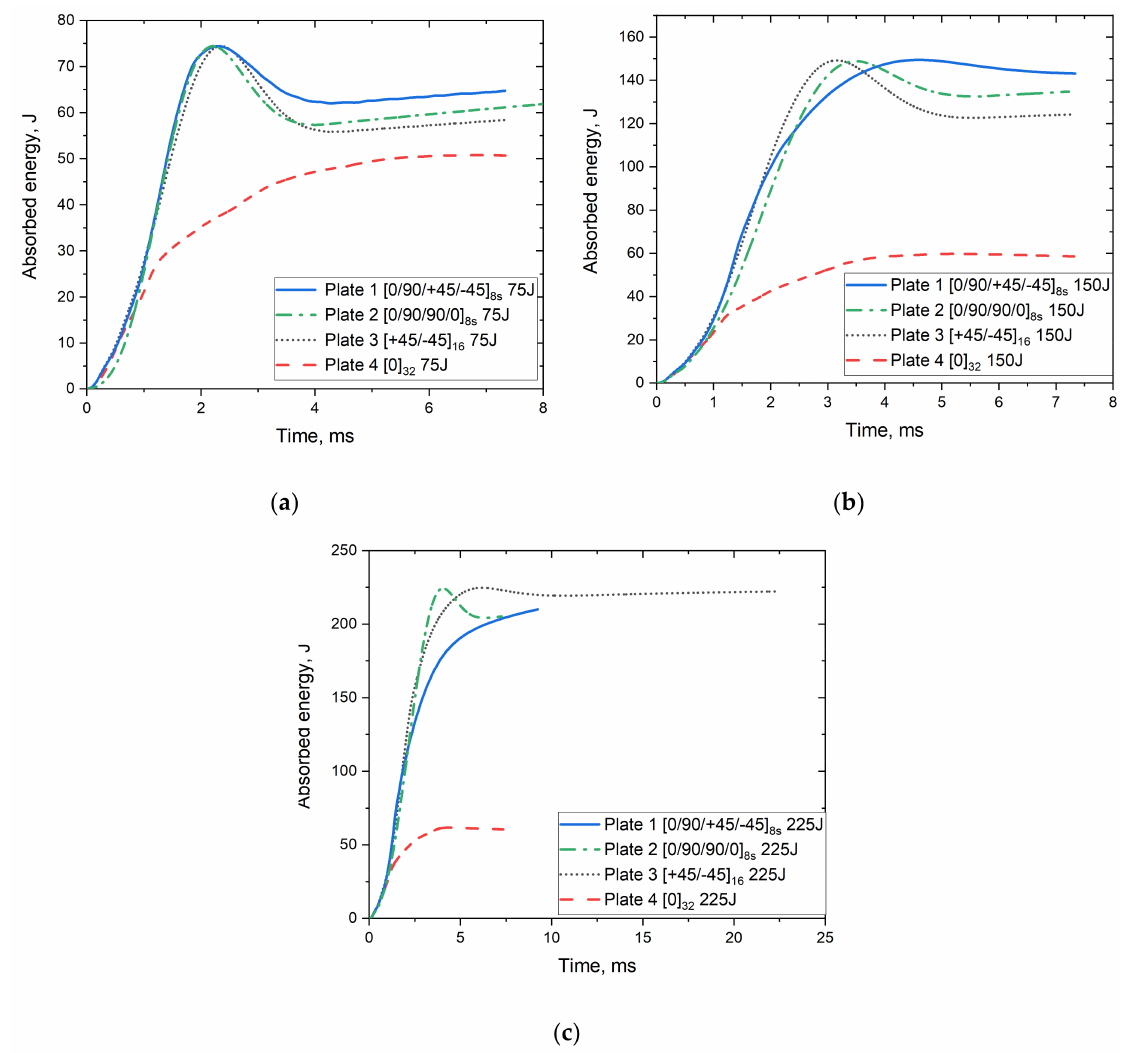
Figure 9. Absorbed energy vs. time curves for S2/FM94 glass fibre plates with different fibre orientation systems under ( a ) 75 J, ( b ) 150 J and ( c ) 225 J impact